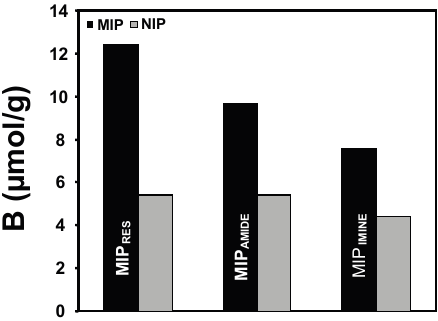
Figure 3. Recognition of ( E )-resveratrol by MIP RES , MIP AMIDE and MIP IMINE . The